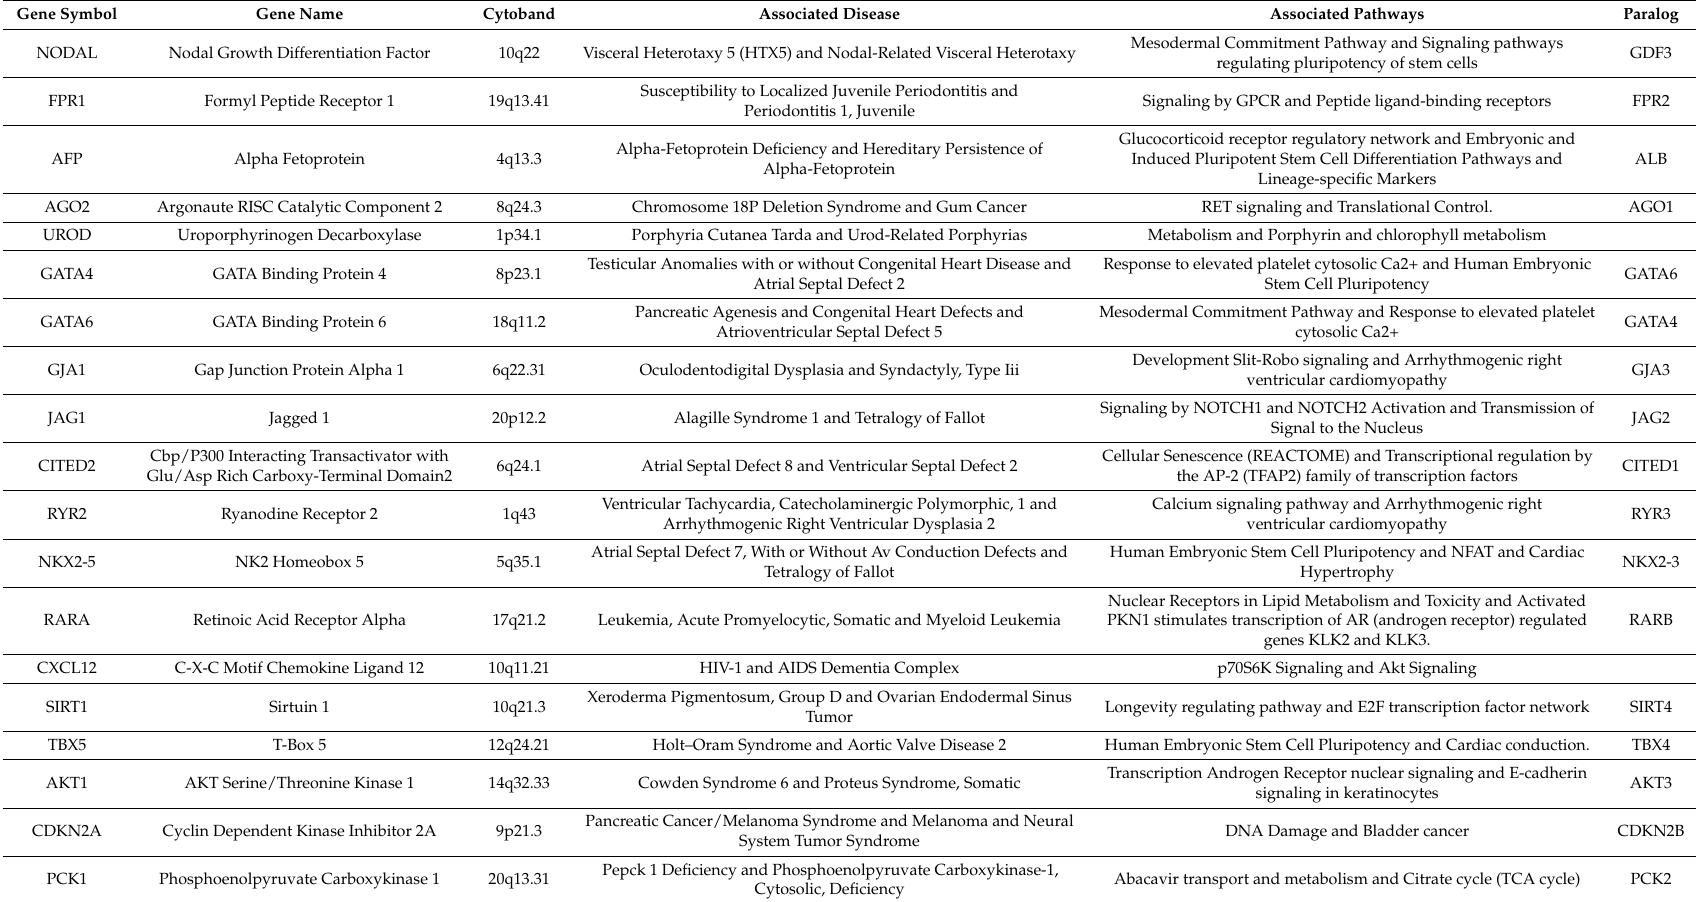
Table 3. Key genes strongly associated with the survival of PS